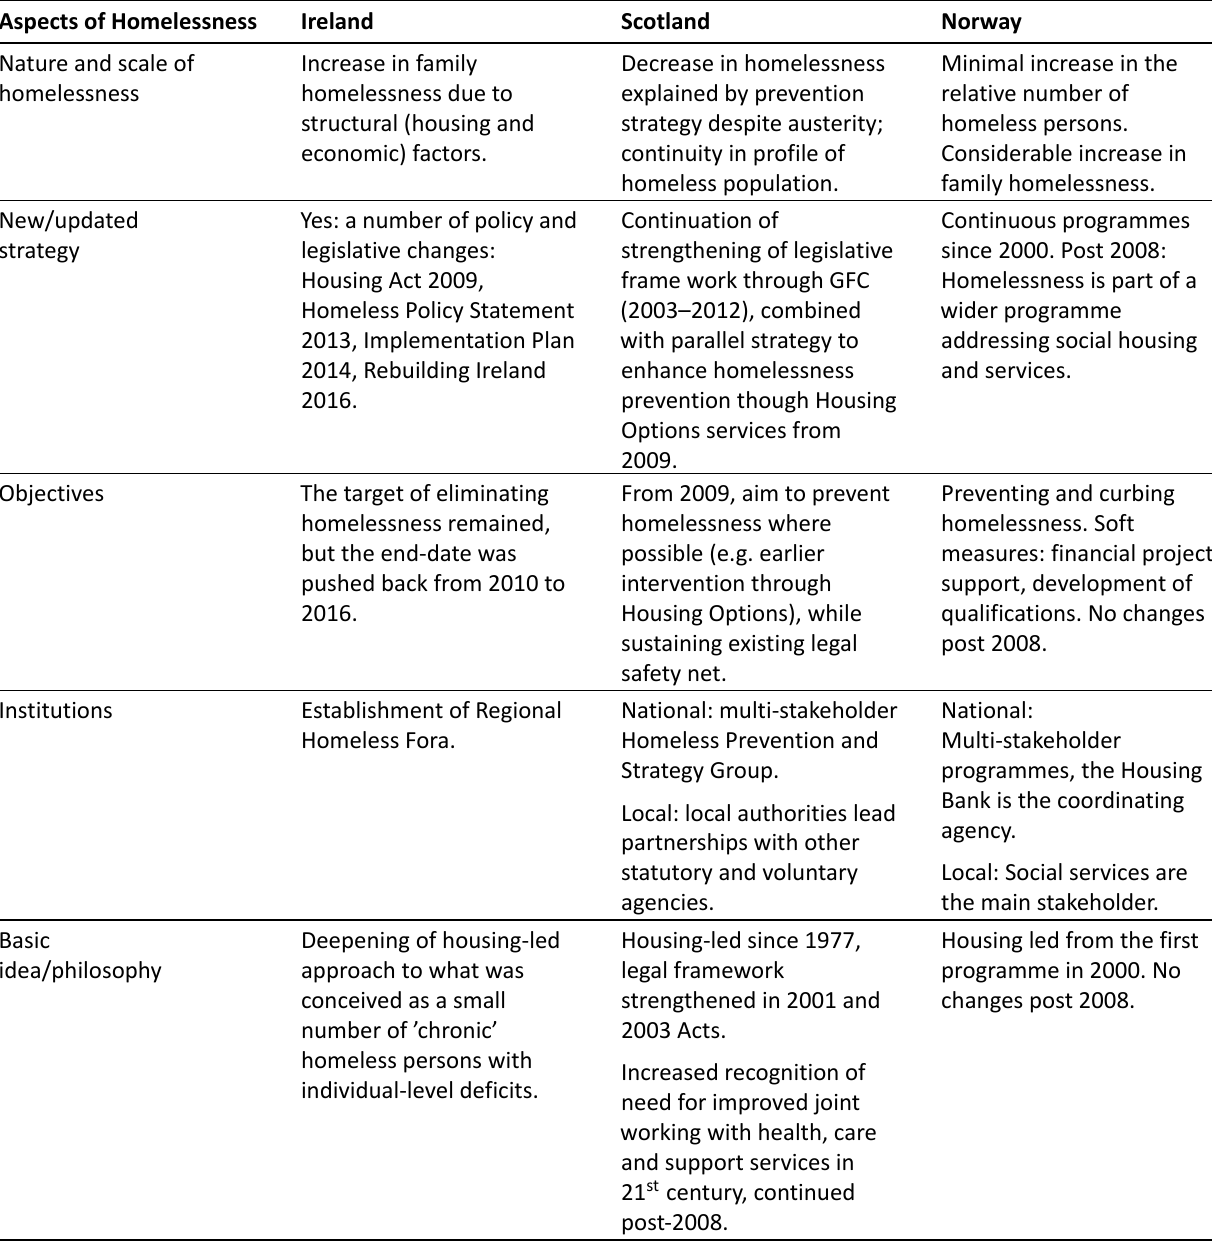
Table 1. Continuities and Changes in aspects of homelessness in post-2008 Ireland, Scotland and Norway. Source: